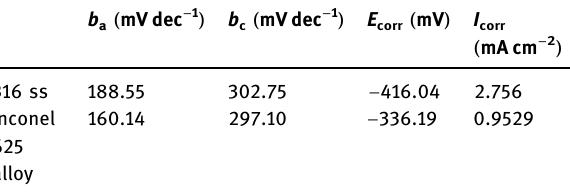
Table 3: Fitting results of polarization curves of 316 stainless steel and Inconel 625 alloy in ternary chloride molten salt at 700°C